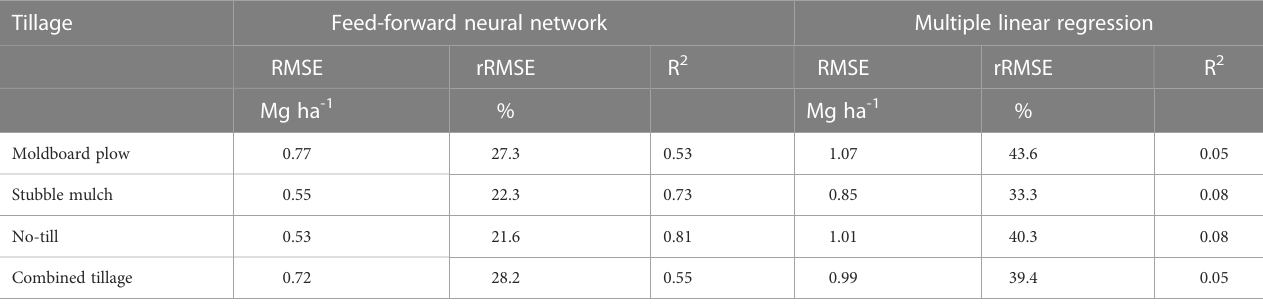
TABLE 2 Performance of models fi t using feed-forward network and multiple linear regression on test data sets.